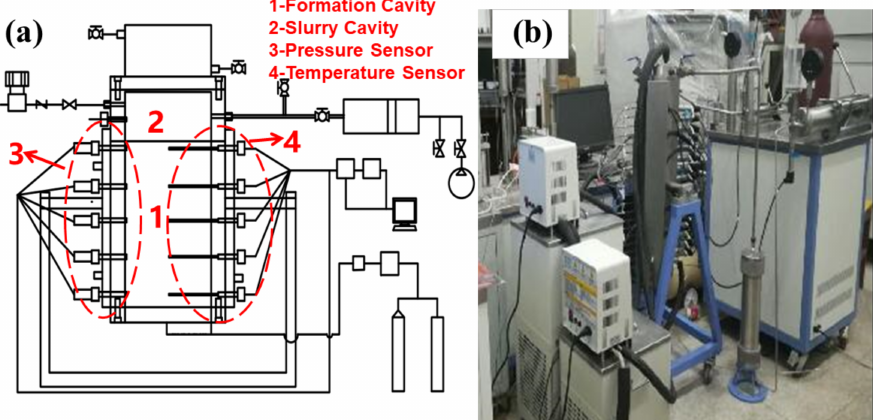
Figure 3. ( a ) Structure chart and ( b ) digital photo of device used to simulate cementing in